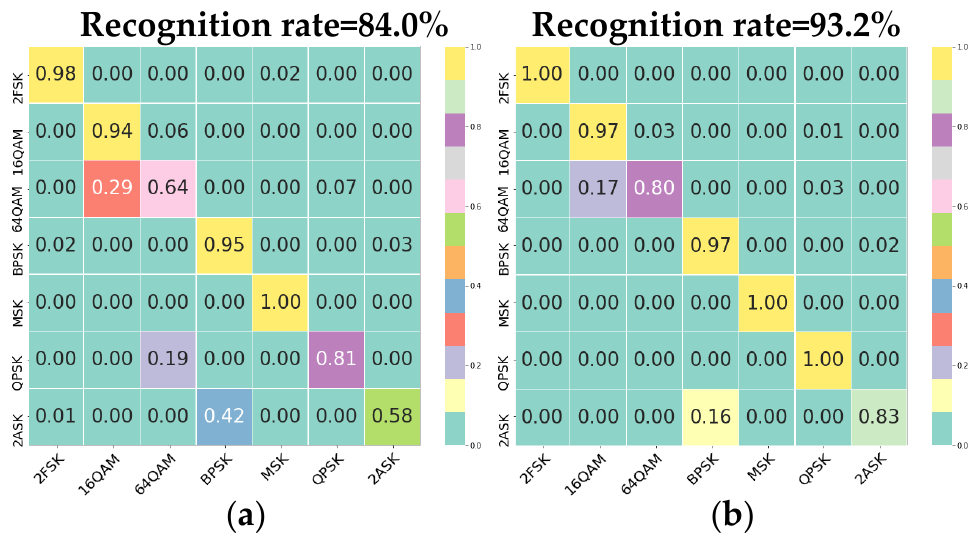
Figure 15. Experimental results on target dataset 3; the signal parameters to be recognized are inconsistent with those of the training set. ( a ) Recognition result of MFHN. ( b ) Recognition result of MJMN.